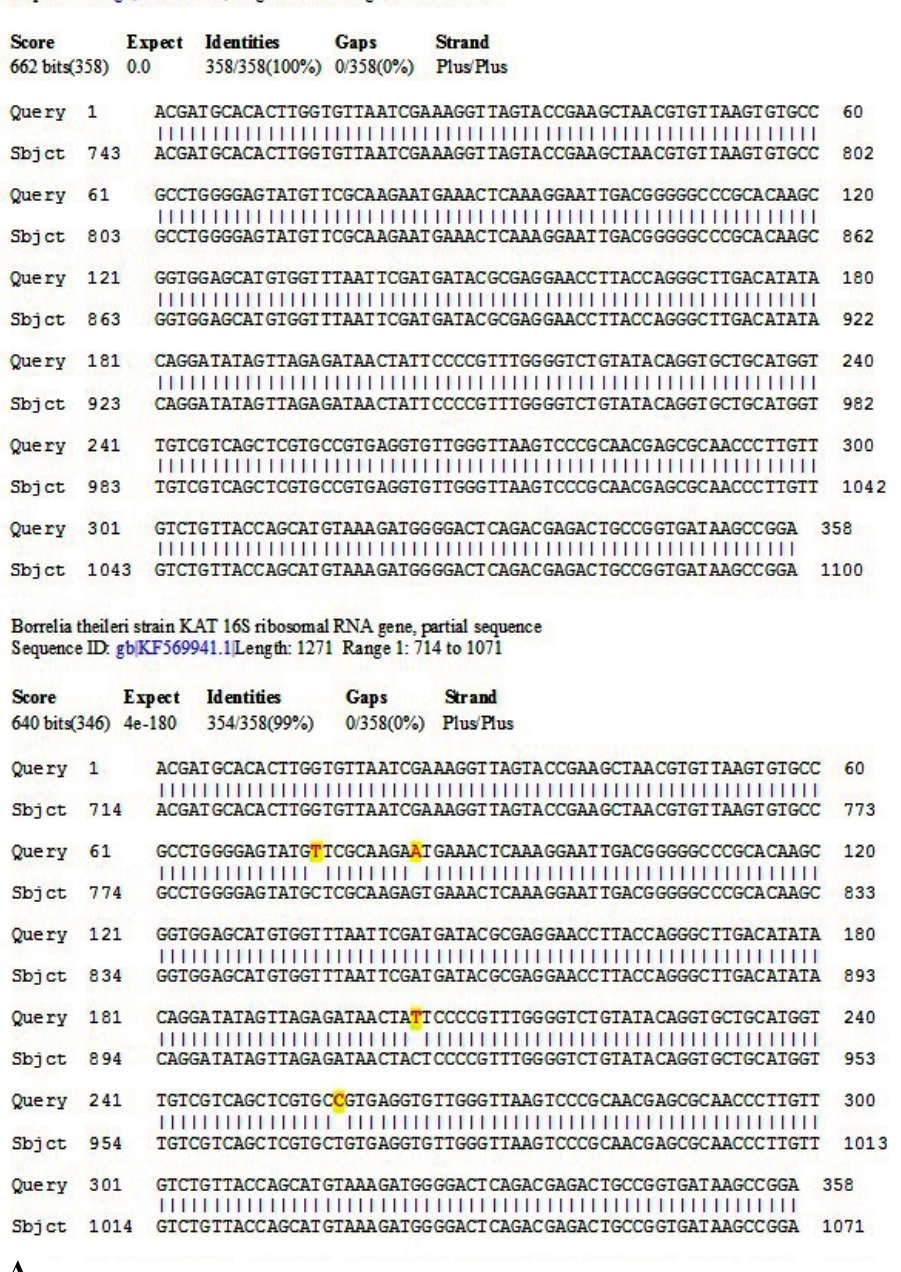
Figure 6. ( A ) A BLAST sequence alignment report from the GenBank validates the sequences illustrated in Figures 2 and 4 are unique partial sequences of the 16S ribosomal RNA gene of the species of B. miyamotoi with a 100% ID match ( upper half ); and the next closest match with 4 discordant bases (high-lighted with red and yellow colors) is that of the 16S ribosomal RNA gene of a B. theileri strain ( lower half ); ( B ) A BLAST sequence alignment report from the GenBank validates the sequences illustrated in Figures 3 and 5 are unique partial sequences of the 16S ribosomal RNA gene of the B. burgdorferi sensu lato complex with a 100% ID match ( upper half ); and the next closest match with one discordant base (high-lighted with red and yellow colors) is that of the 16S ribosomal RNA gene of a B. valaisiana strain ( lower half